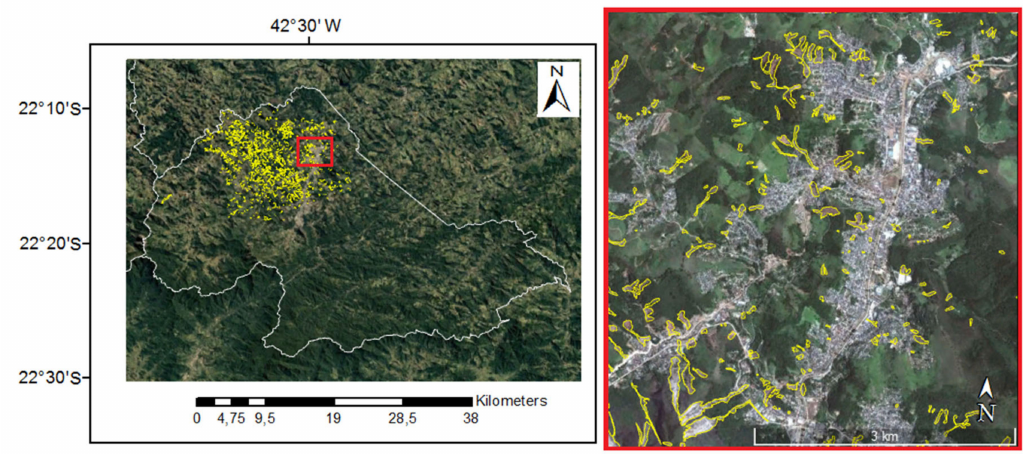
Figure 3. Nova friburgo landslide scars mapped on the google earth image in 19 January